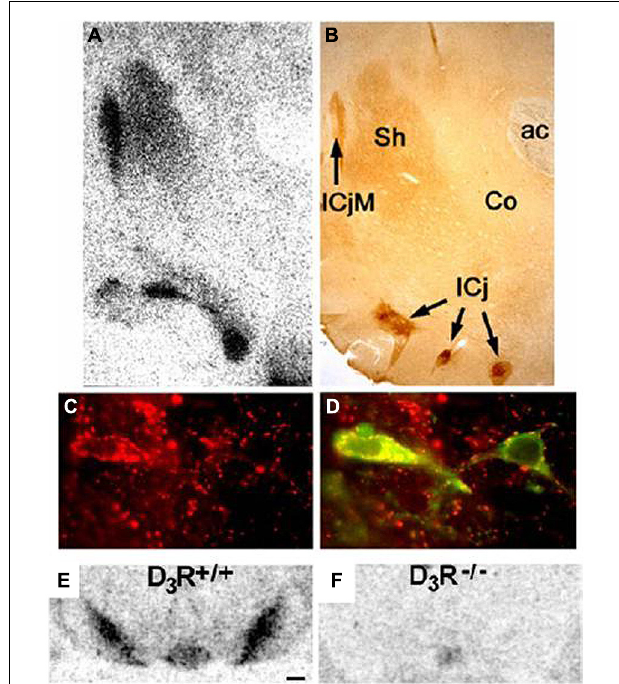
FIGURE 1 | Distribution of D3 receptors: immunohistochemical localization of the DRD3 in rat brain. (A,B) Superimposable distributions of binding of [ 125 I] trans -7-OH-PIPAT, a DRD3-selective ligand (A) , and DRD3 immunoreactivity (B) , with highest levels in the islands of Calleja (IcjM and IC) and moderate levels in the shell of nucleus accumbens (Sh); ac, anterior commissura. (C,D) Expression of DRD3 immunoreactivity alone (in red in C ) and in combination with tyrosine hydroxylase immunoreactivity (in green in D ). All tyrosine hydroxylase-positive neurons in the mesencephalon express the DRD3. Distribution of the binding of [ 125 I] trans -7-OH-PIPAT in SN/VTA of D3R + / + mice (E) and of D3R − / − mice (F) . Adapted with permission from Diaz etal.